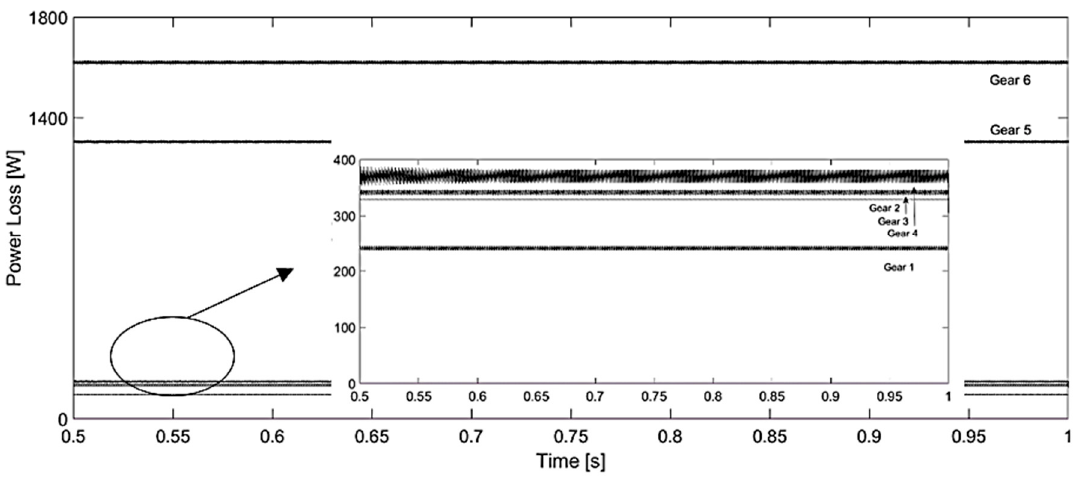
Figure 10. Power losses for uncoated gears, scenario 1.